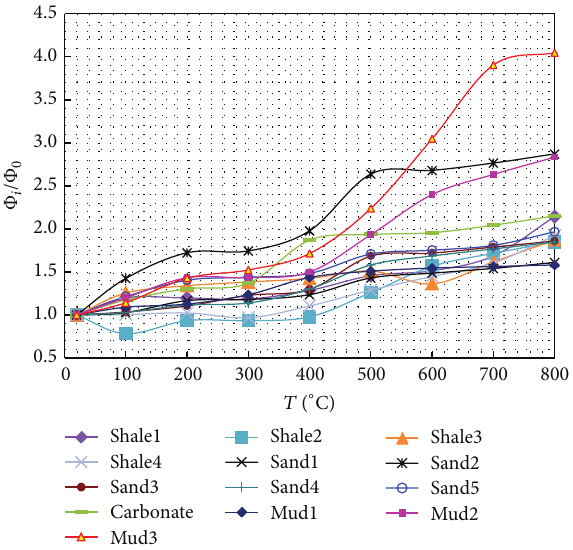
Figure 6: Normalized porosity as a function of treatment tempera- ture for all the